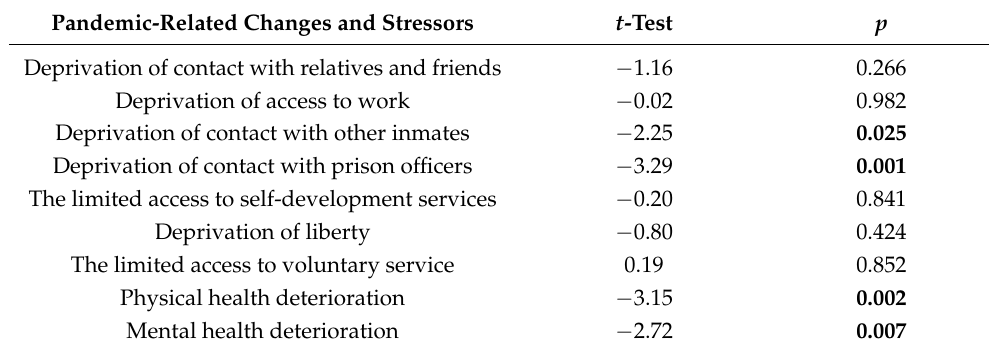
Table 3. Differences between mean values for pandemic-related changes and stressors obtained in the group of inmates who were (N = 109) and were not infected with SARS-CoV-2 (N = 141). Pandemic-Related Changes and